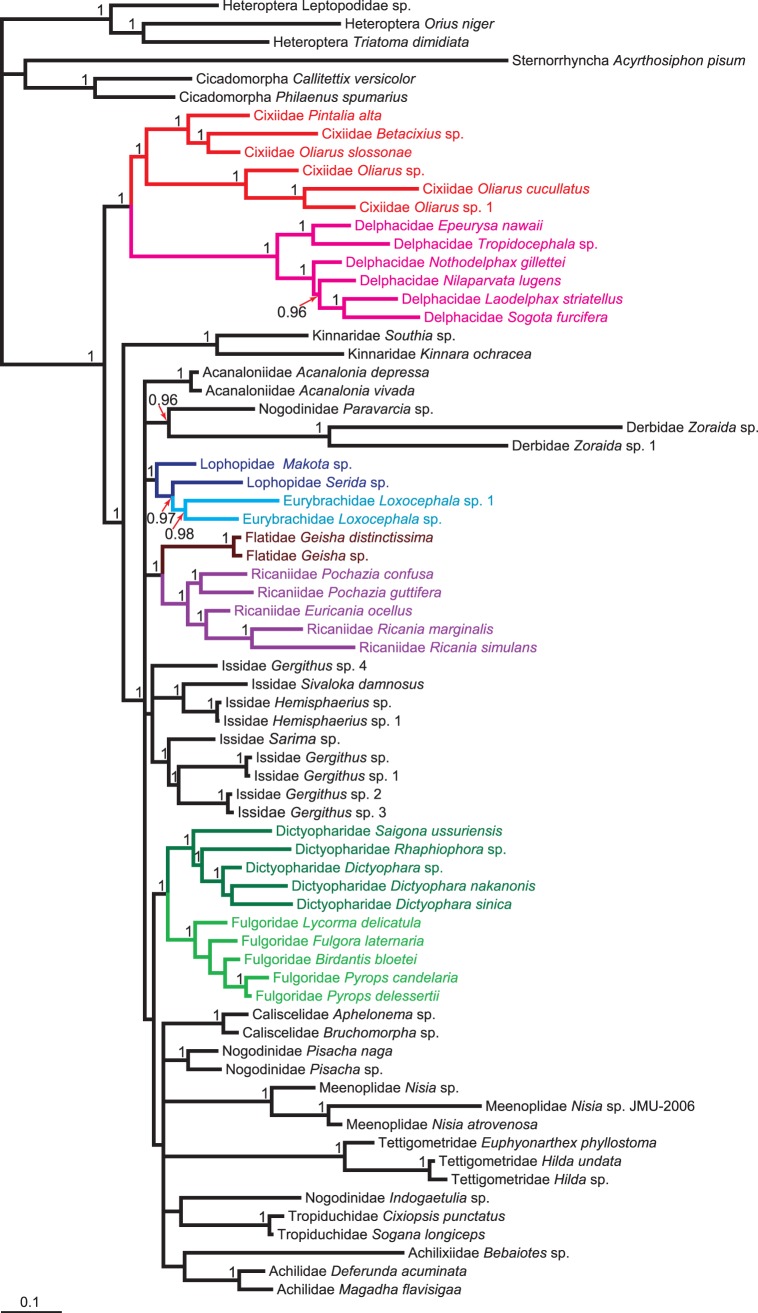
The 50% majority-rule consensus tree estimated from the Bayesian analysis based on the combined dataset.Values above branches denote posterior probabilities (≥0.9).